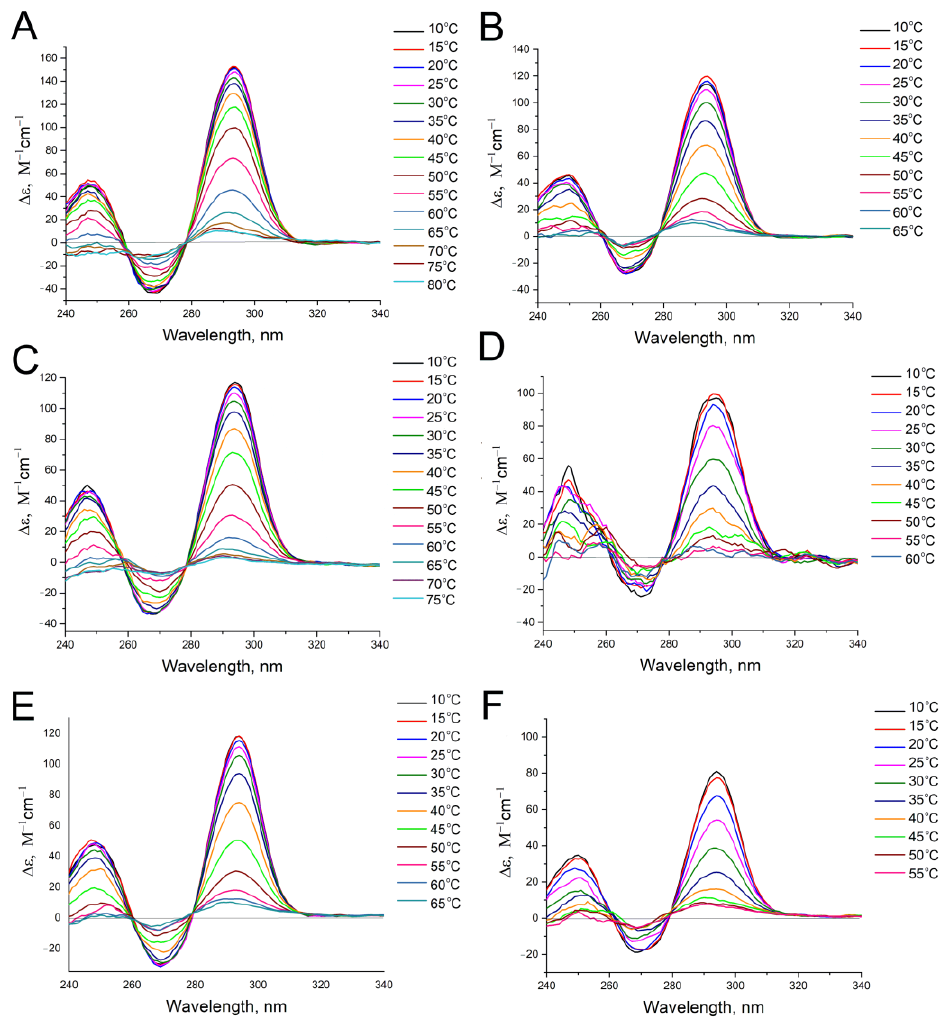
Figure 7. Circular dichroism spectra obtained at different temperatures for the aptamers: ( A ) K + -coordinated amino-T4,T13-HD1; ( B ) Na + -coordinated amino-T4,T13-HD1; ( C ) K + -coordinated amino-T13-HD1; ( D ) Na + -coordinated amino-T13-HD1; ( E ) K + -coordinated amino-T3,T12-HD1; ( F ) Na + -coordinated amino-T3,T12-HD1.